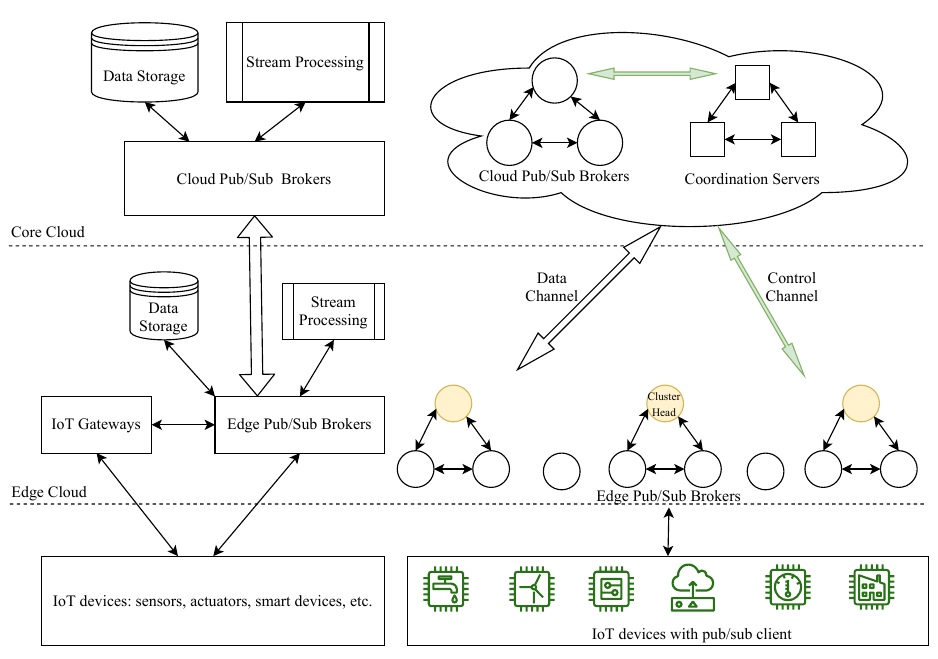
Figure 1. The system